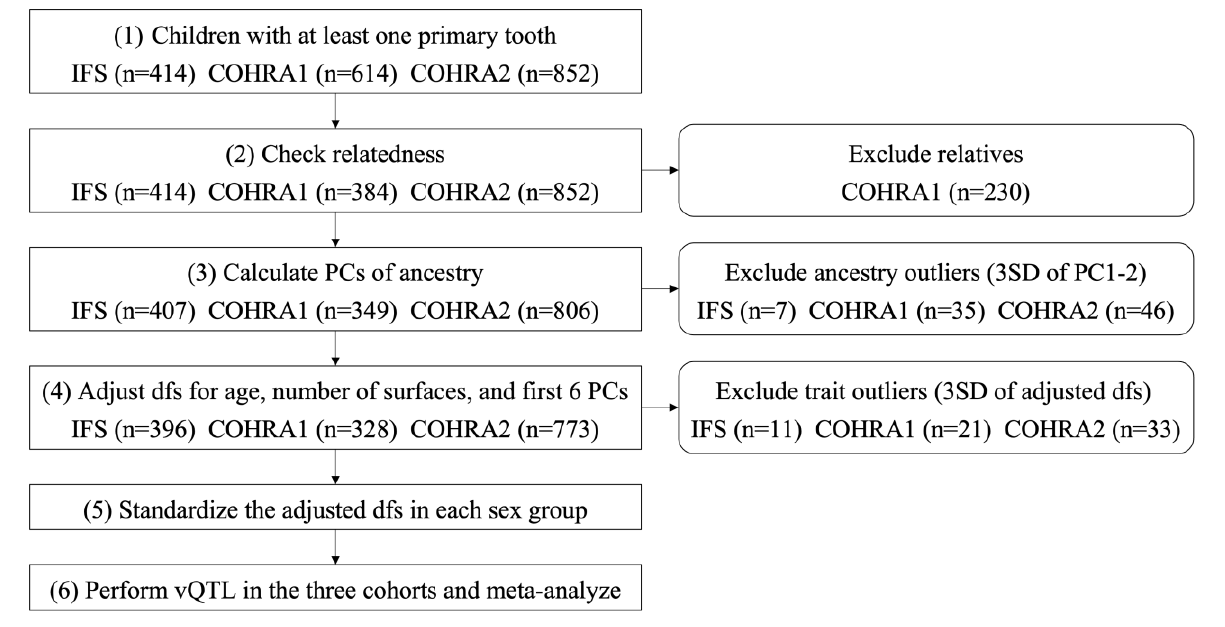
Figure 1. Participant process workflow.